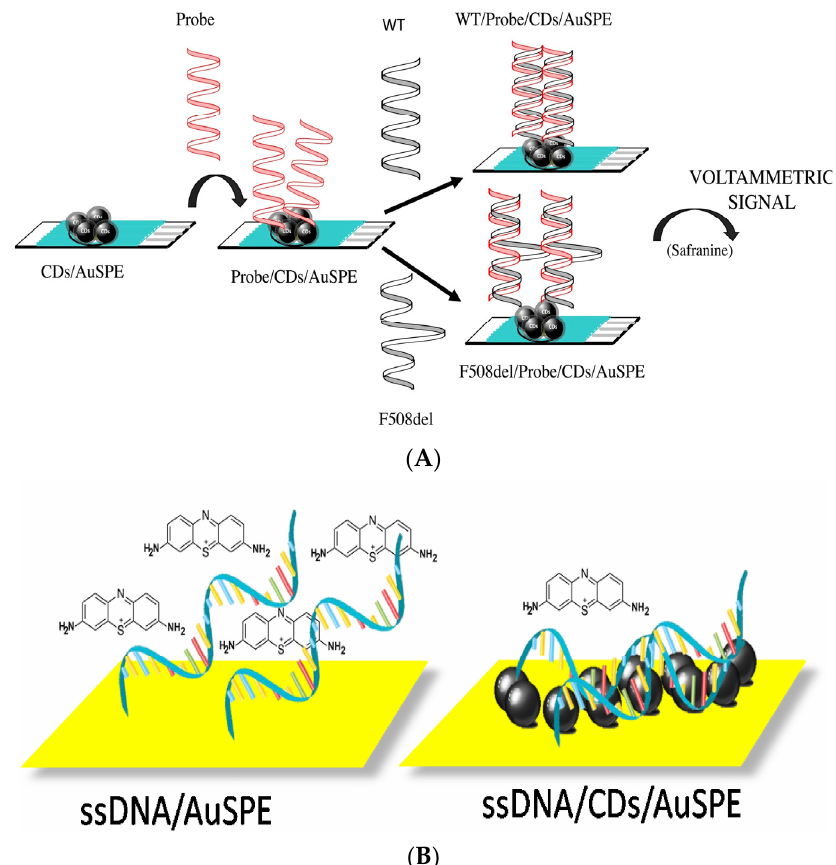
Figure 12. ( A ) Mechanism of operation of an electrochemical genosensor for BRCA1 gene detection using thionine as redox indicator (variant with and without the presence of carbon dots at the interphase), and ( B ) a genosensor for Helicobacter pylori detection based on a screen-printed electrode coated with carbon dots, using safranine (SAF) as redox marker. Adapted with permission from